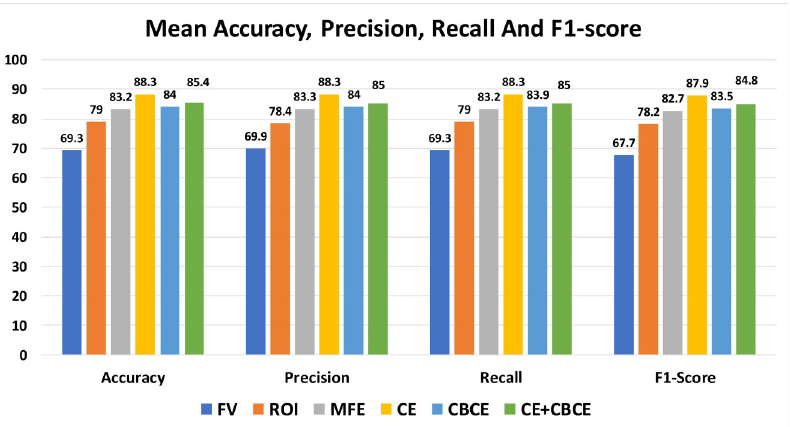
Fig 5. Accuracy, precision, recall and F-1 score of all feature extraction methods across each optimization algorithms.